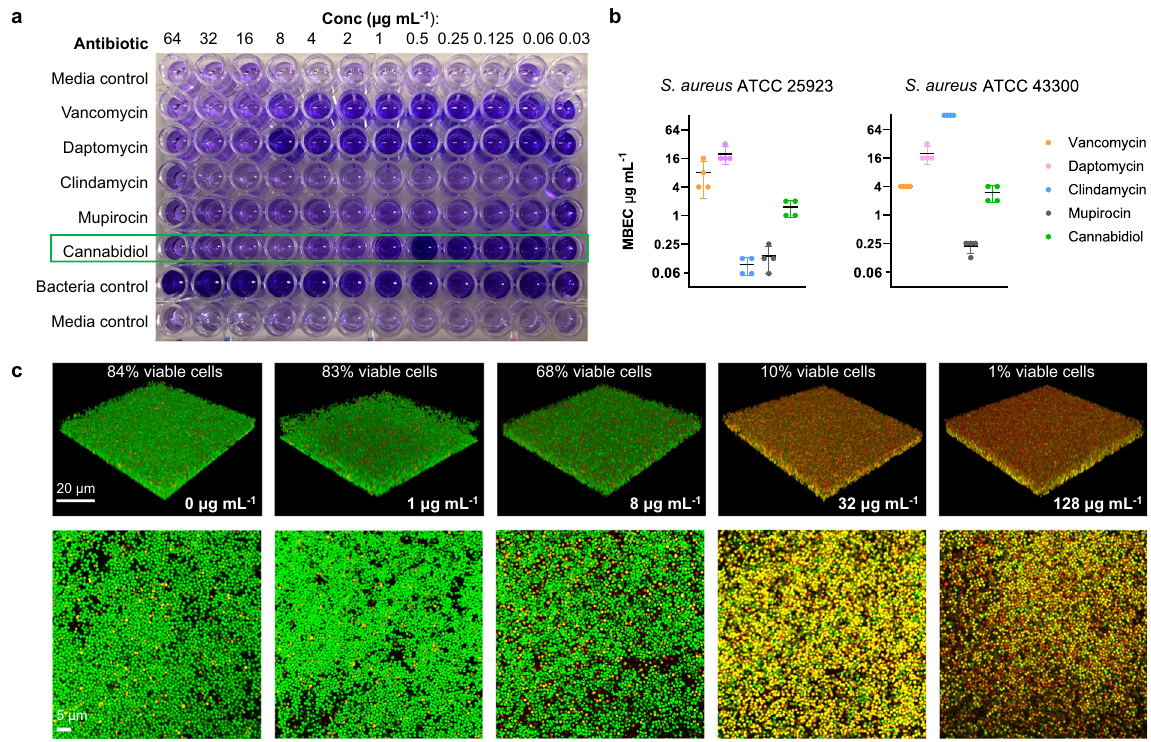
Fig. 2 Anti-bio fi lm activity of cannabidiol. Minimum bio fi lm eradication concentration (MBEC) assessment of CBD using crystal violet staining ( a ) to assess ( b ) MSSA ATCC 25923 and MRSA ATCC 43300 bio fi lm remaining after 24 h incubation with CBD, vancomycin, daptomycin, trimethoprim, mupirocin, or clindamycin (bio fi lm initially established by 48 h growth in TSB + 5% glucose). Data are n = 4 biologically independent samples. c Confocal microscopy of MRSA ATCC 43300 bio fi lm grown on microscope slides, then treated with CBD at varying concentrations for 24 h. Slides were then stained with SYTO 9 (green, indicates live + dead cells) and propidium iodide (red, indicates dead cells) nucleic acid stains (white scale bars represent 20 µ m in the 3D panels and 5 µ m in the 2D